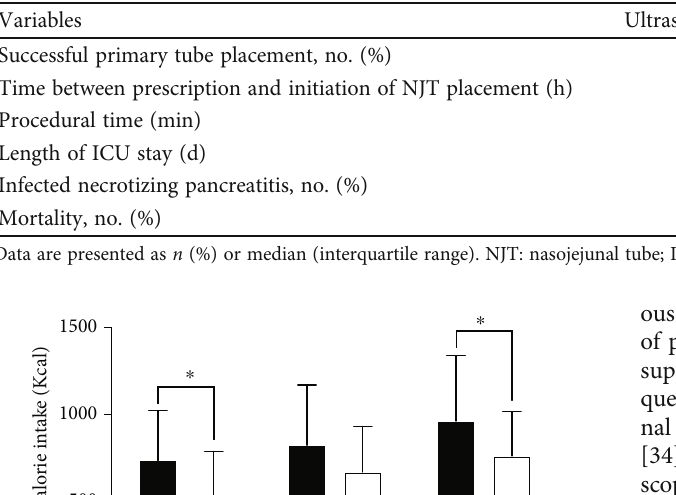
Table 2: Clinical outcomes.